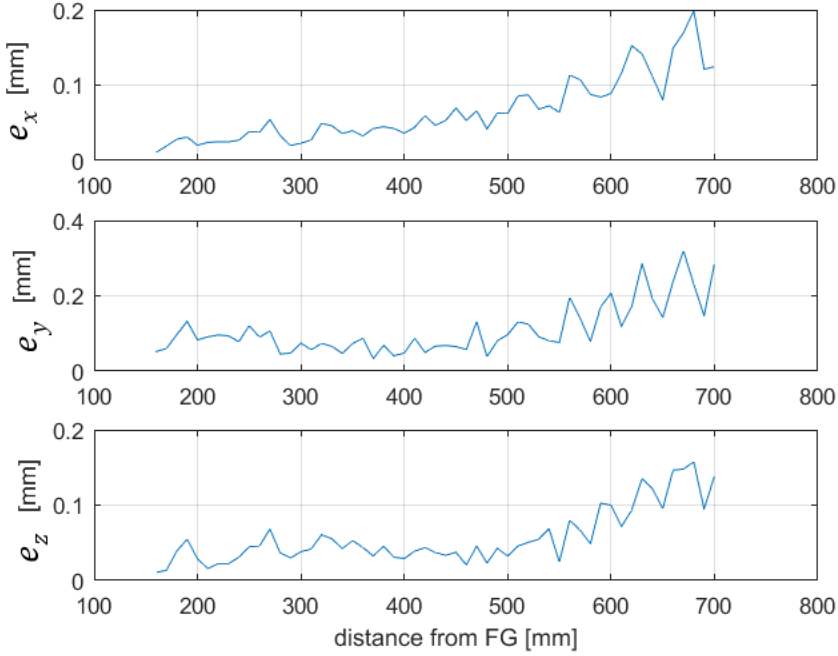
Figure 11. Position errors caused by drift, obtained by repeating the same measurements after 90 min and applying the estimation through gradients.